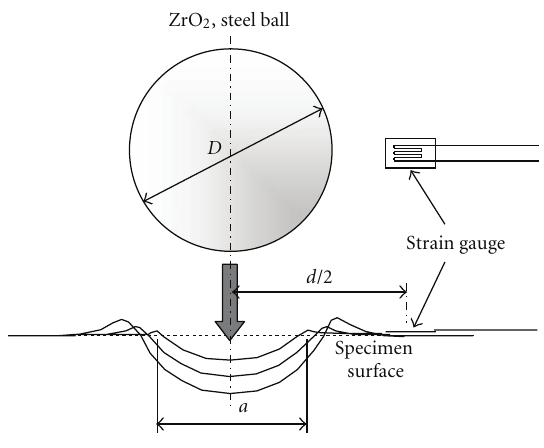
Figure 2: Schematic illustration of measuring compressive strains during an indentation